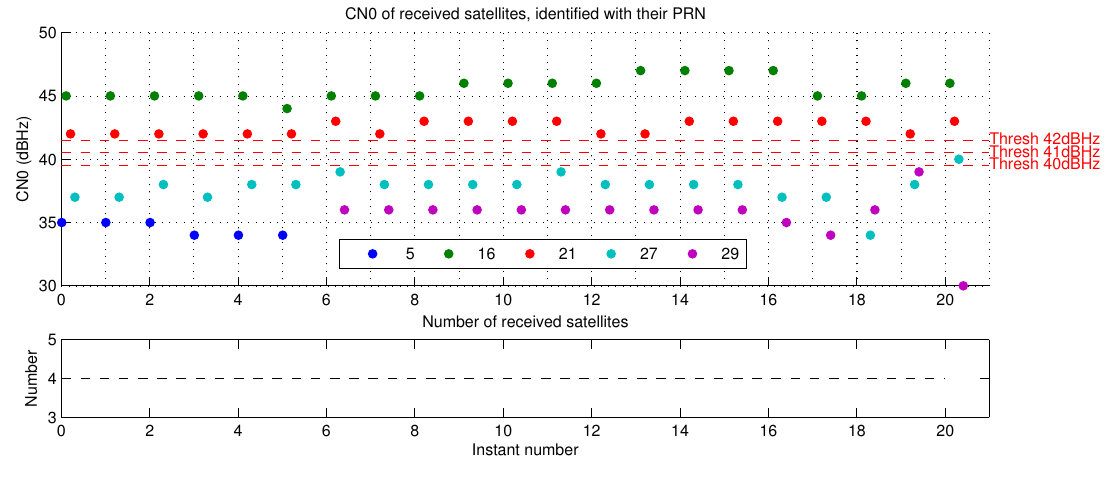
Figure 18. Satellites CN0 for sequence